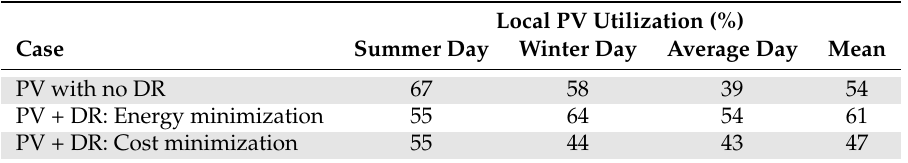
Table 11. PV utilization with and without demand response